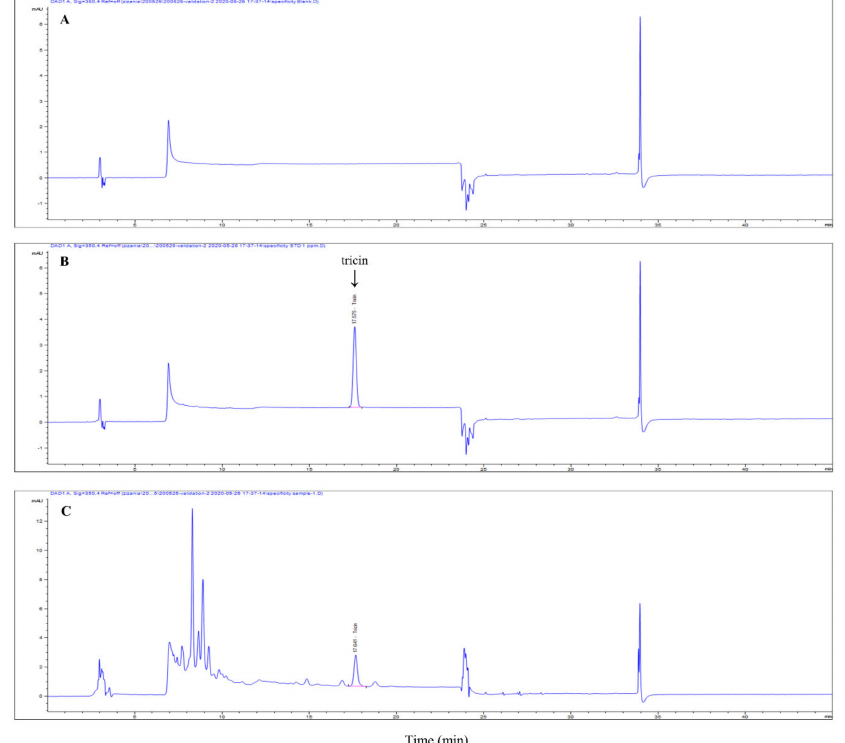
Figure 1. HPLC chromatograms of ( A ) blank, ( B ) tricin standard and ( C ) enzyme-treated Z. latifolia extract